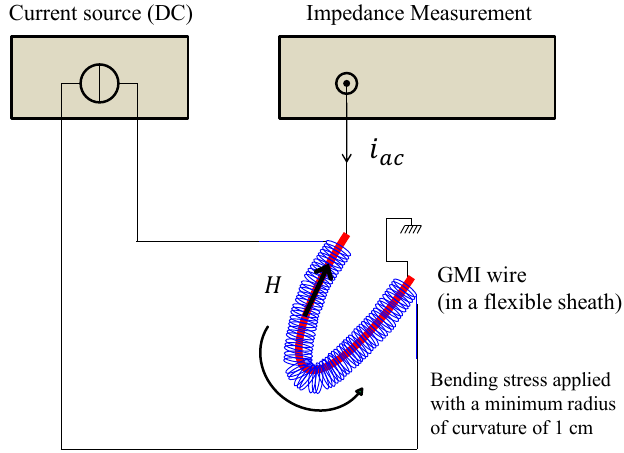
Figure 2. The experimental setup. The GMI wire was 90 mm in length and excited by an AC current with a 1 mA amplitude and a 1 MHz frequency. In this figure, the wire is in a bent